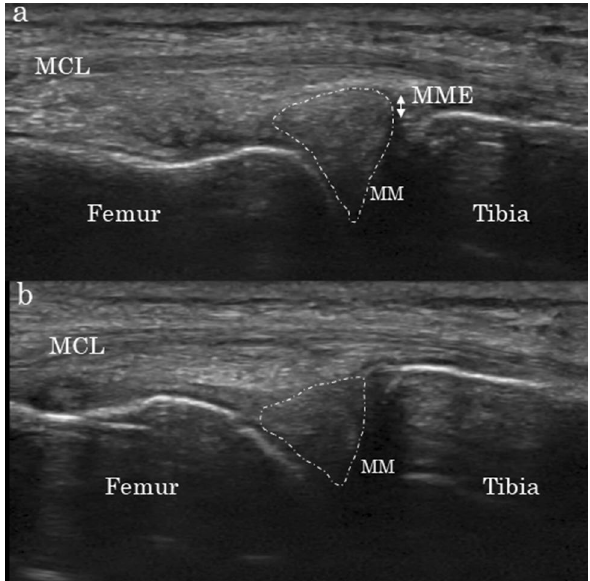
Figure 1. Change in MME from a knee flexion angle of 0° ( a ) to 90° ( b ) in a healthy adult. The medial meniscus that is slightly extruded at a knee flexion angle of 0° is retracted into the joint by knee flexion, at which point the extrusion disappears. MM is indicated by the dotted line. MCL medial collateral ligament, MME medial meniscal extrusion, MM medial